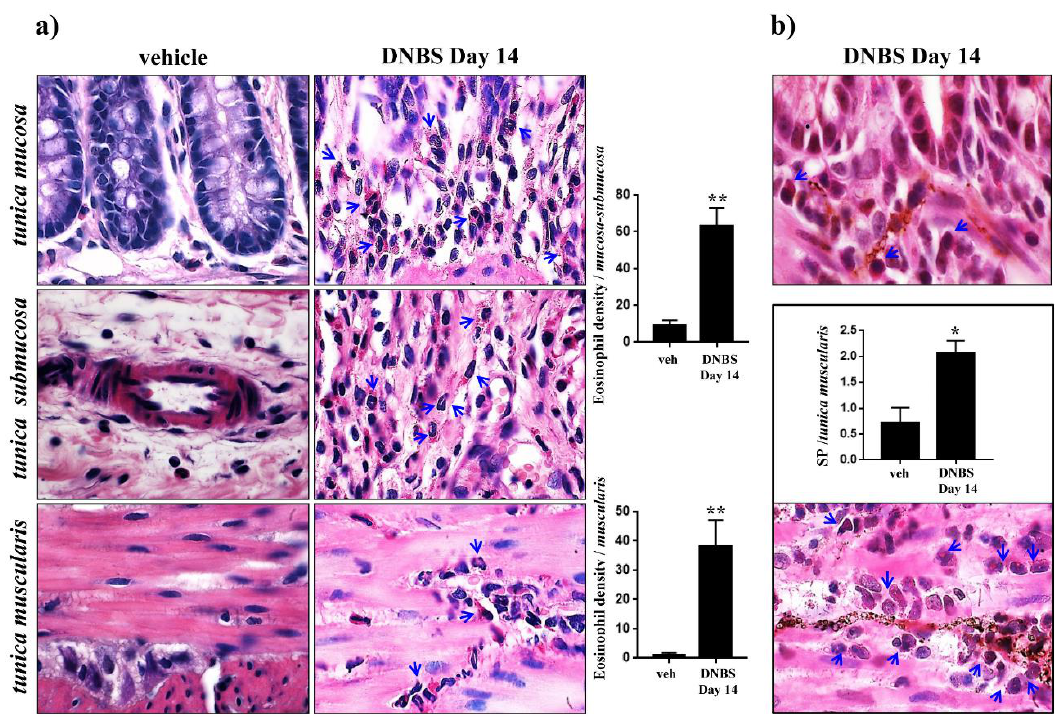
Figure 5. Eosinophil infiltration of colonic wall in close proximity to SP-positive fibers 14 days after DNBS injection. Representative pictures of colonic sections stained with: ( a ) hematoxylin / eosin (eosinophils, arrows) and ( b ) hematoxylin / eosin and SP immunoperoxidase. The right panel ( b ) shows pictures captured from tunica mucosa (up) and muscularis (down). For each animal, 5 randomly selected microscopic fields from 2 non-adjacent sections were evaluated. The total numbers of counted eosinophils were 5–18 (vehicle) and 42–88 (DNBS) / 0.41 mm 2 in the tunica mucosa-submucosa and 1–2 (vehicle) and 20–61 (DNBS) / 0.41 mm 2 in the tunica muscularis . Column graphs display the mean values of eosinophil density per mm 2 of colonic wall areas (cells / mm 2 ) ( a ), and positive pixels percentage (PPP) of SP-reactive fibers ( b ) ± S.E.M. obtained from 4 animals for each group. * p ≤ 0.05, ** p ≤